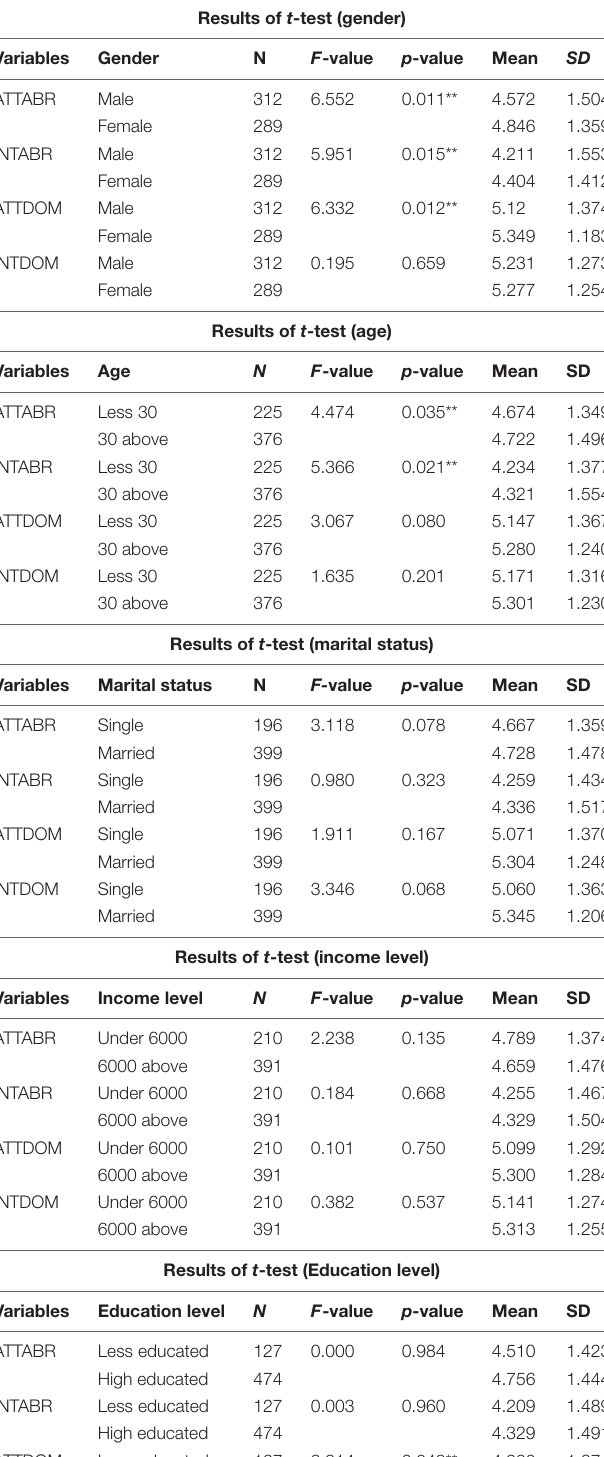
TABLE 6 | T -test results.